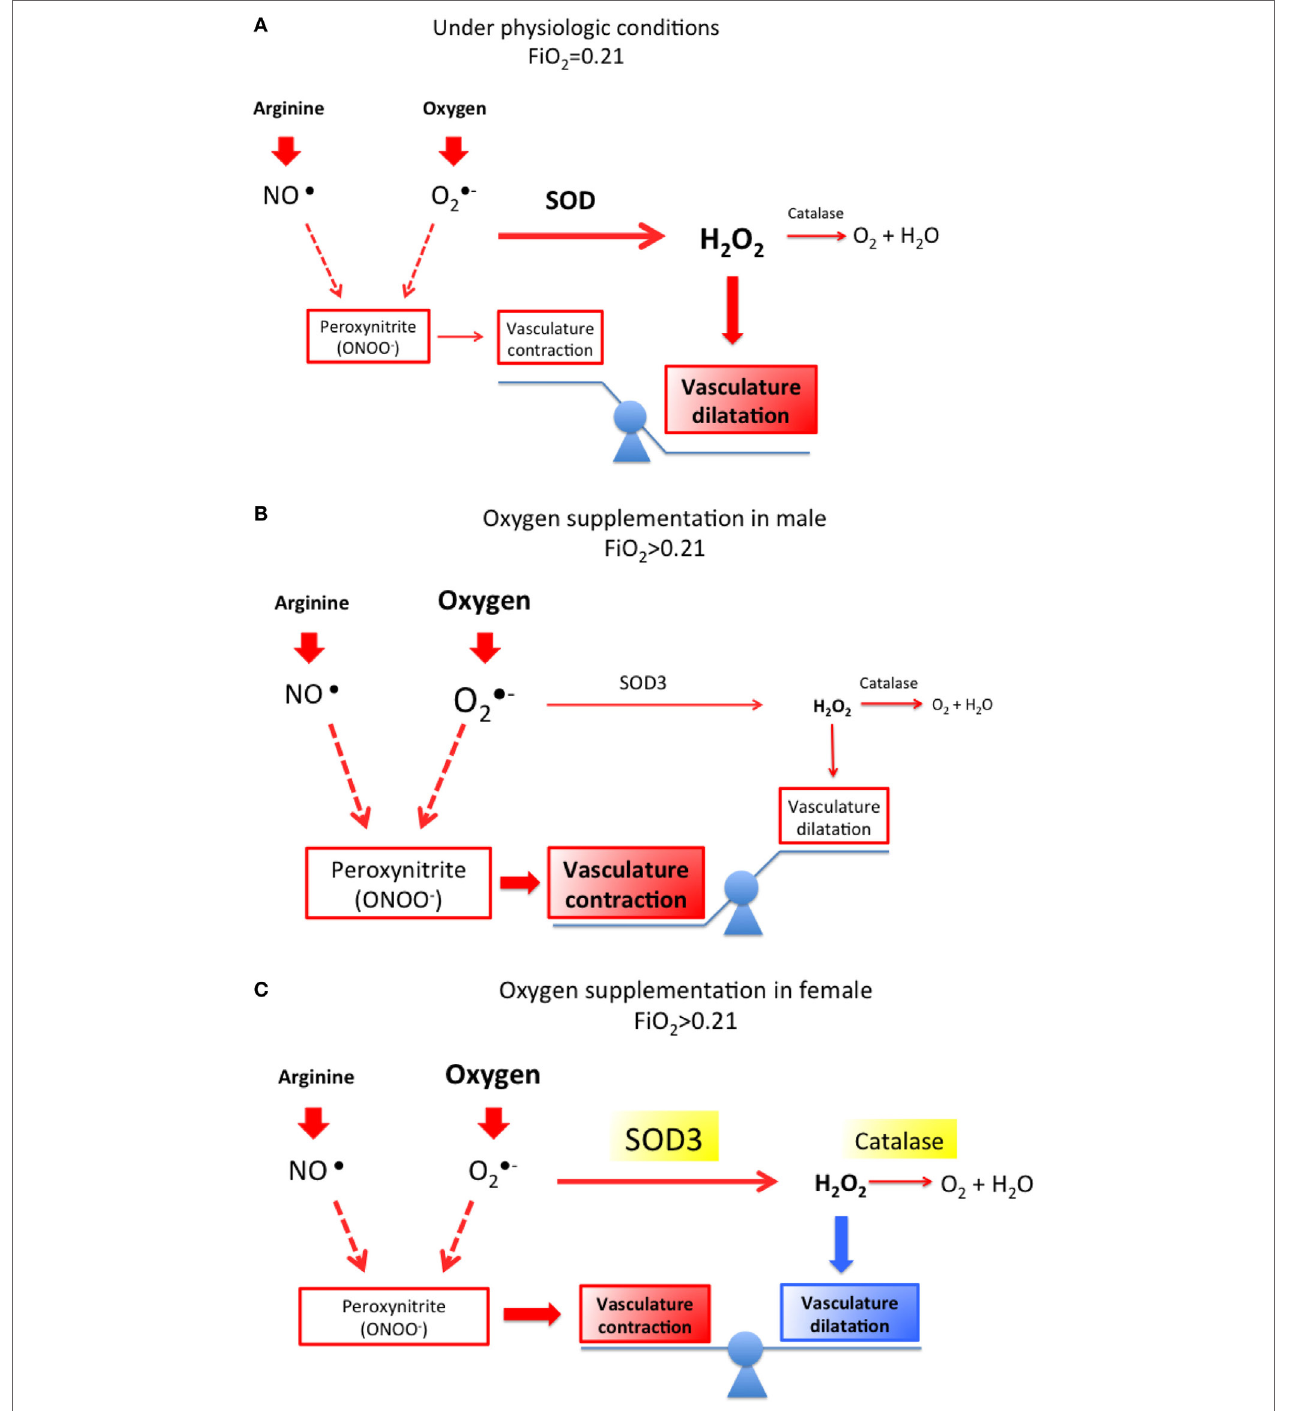
FiGURe 2 | (A) Under normal circumstances, the vasodilating action of oxygen and nitric oxide (NO) and other vasodilating agents overcome the vasoconstrictive action triggered by oxygen (superoxide) and nitrogen free radicals (peroxynitrite) through the action of superoxide dismutases (SOD3). (b) However, supplementation with high oxygen concentration may lead to an increased generation of free radicals that may overcome the neutralizing effect of SOD3 (extracellular SOD) and lead to vasoconstriction. (C) Enhanced expression of SOD3 in females is highly protective toward the development of pulmonary vasoconstriction at birth especially in preterm